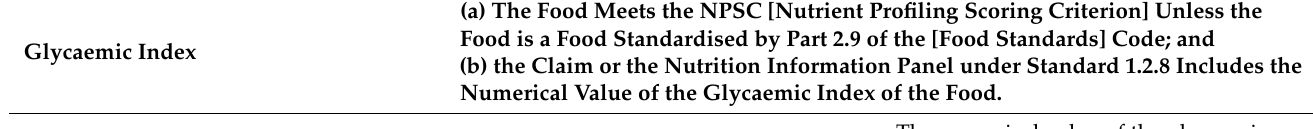
Table 1. Food Standards Australia New Zealand’s Food Standards Code regulations for Glycaemic Index [2].